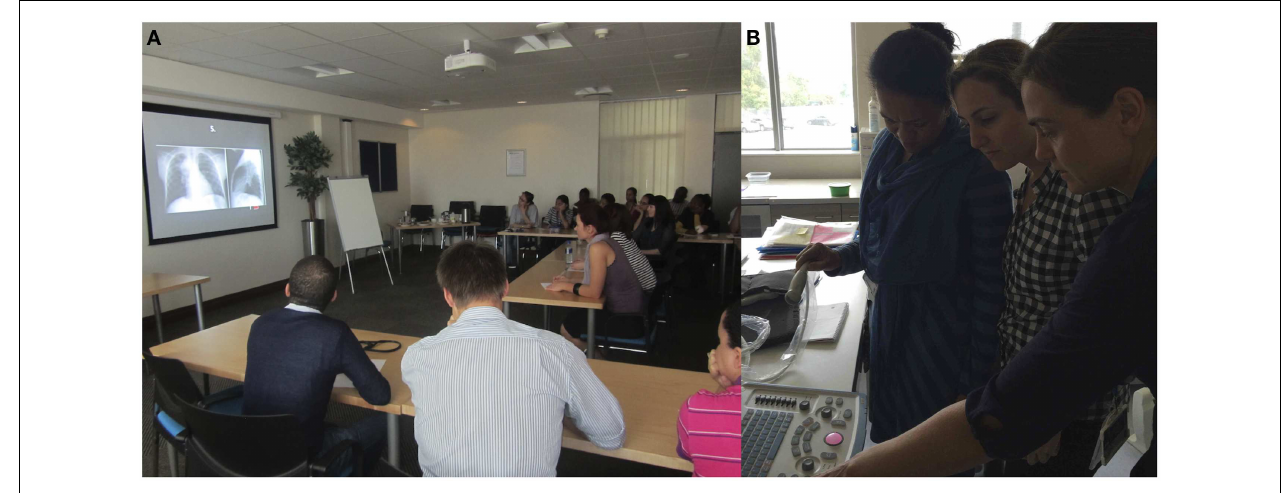
Pediatric Imaging).This program was run twice in parallel with the pilot telereading program, intended to increase capacity for X-ray interpretation on the ground. (B) Point of care mediastinal sonography for the diagnosis of tuberculosis being taught to a non-radiologist by a representative of Imaging theWorld in co-operation with theWorld Federation of Pediatric